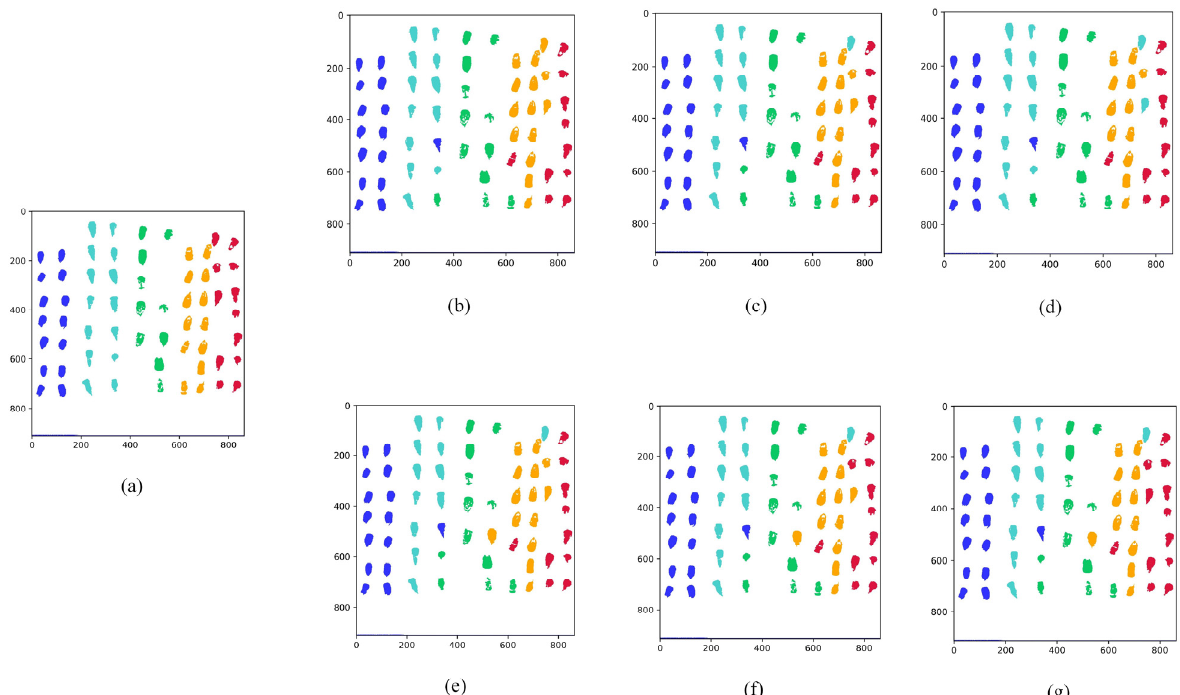
Figure 12. Visualization of predicted moldy maize seeds. ( a ) Different mold visualization images; ( b ) 462-band RF model prediction visualization map; ( c ) 462-band SSA-RF model prediction visualization map; ( d ) 462-band JYSSA-RF model prediction visualization map; ( e ) 186-band RF model prediction visualization map; ( f ) 186-band SSA-RF model prediction visualization map; ( g ) 186-band JYSSA-RF model prediction visualization map.